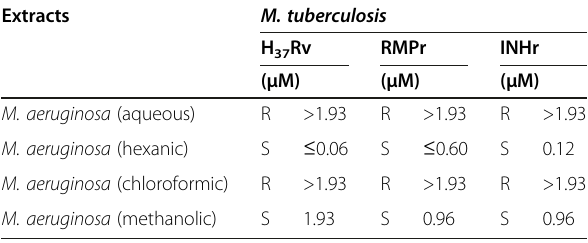
Table 1 Minimum inhibitory concentration (MIC) of different Microcystis aeruginosa extracts against Mycobacterium tuberculosis strains